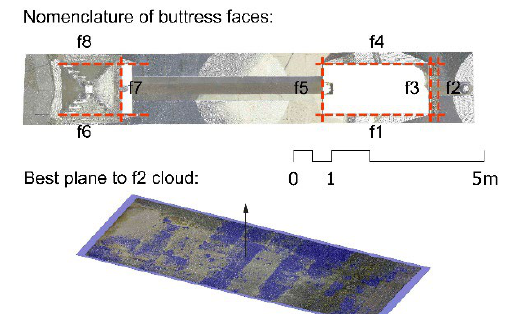
Figure 6: Study of flatness by means of the best plane and buttress nomenclature.